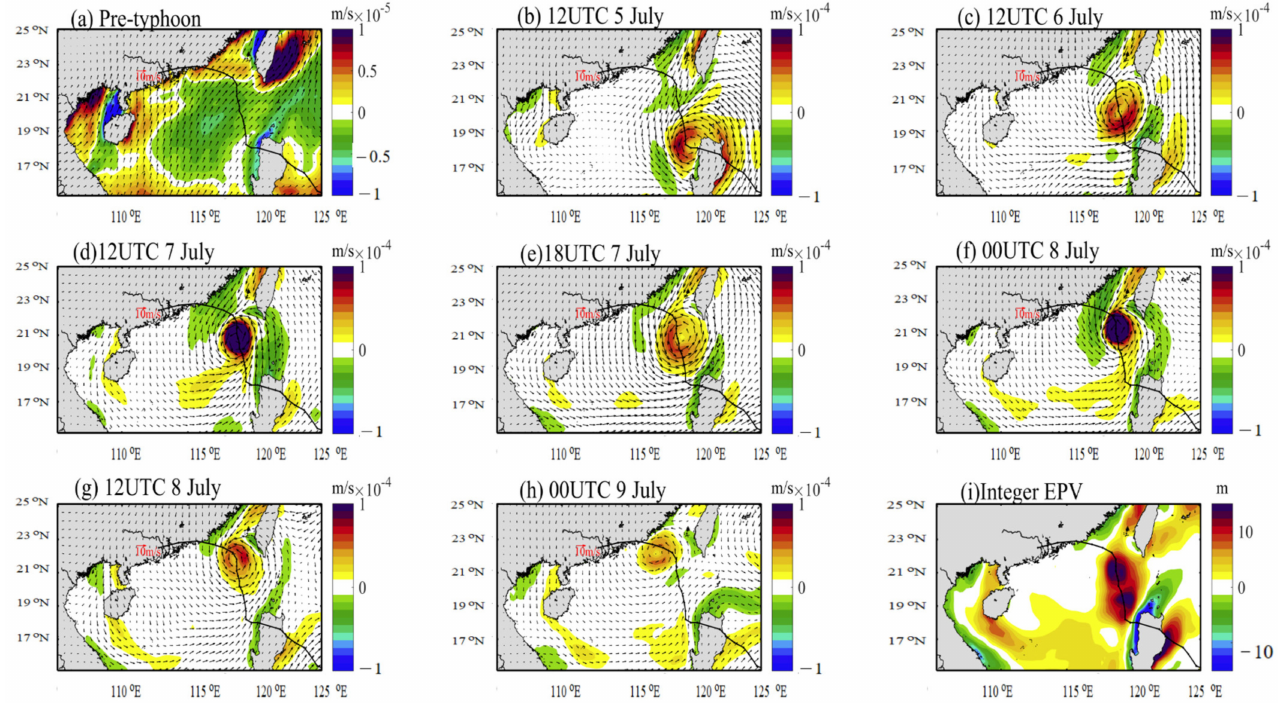
Figure 10. Spatial distribution of 10 m wind vector (arrows) and Ekman pumping velocity (shading) during pre-typhoon ( a ) 1–4 July, on 12UTC 5 July ( b ), 12UTC 6 July ( c ), 12UTC 7 July ( d ), 18UTC 7 July ( e ), 00UTC 8 July ( f ), 12UTC 8 July ( g ), 00UTC 9 July ( h ) and 00UTC 9 July ( i ), and Integer Ekman pumping velocity. The black line denotes typhoon